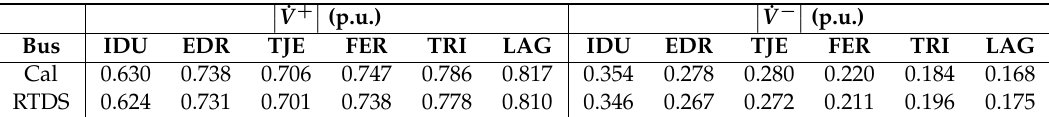
Table 7. Comparison between calculations and simulations (A–g